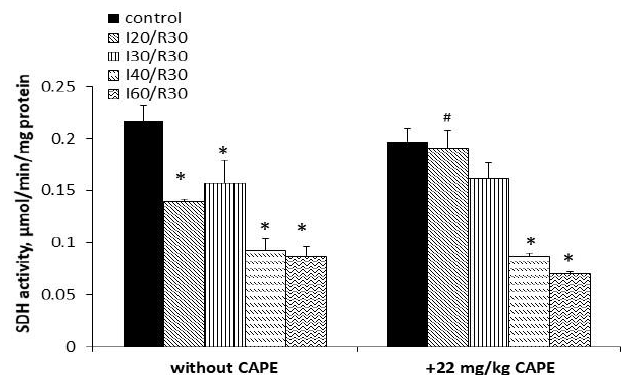
Figure 8. Effect of ischemia/reperfusion and CAPE on SDH (Complex II) activity in the kidney mitochondria. The SDH activity was measured spectrophotometrically at 600 nm, as described in the Materials and Methods section. * p < 0.05 vs. the respective control; # p < 0.05 vs. ischemia/reperfusion without CAPE. One-way ANOVA followed by a Fisher’s LSD post hoc test were used to compare the effects.